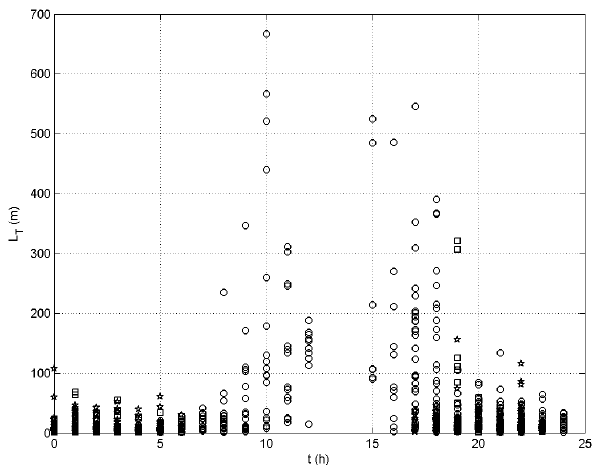
Figure 3. Time evolution of the Thorpe scale during a day cycle. The symbols are as follows: ◦ is for Almaraz94-95 data, (cid:63) is for Sables98 data, and (cid:3) is for Sables2006 data. The error of Thorpe displacements is ±